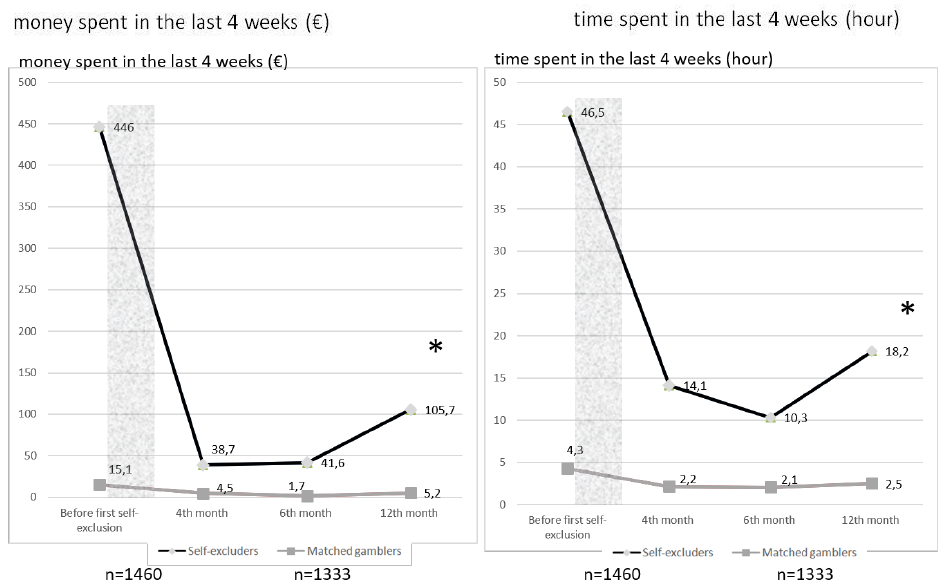
Figure 3. Evolution of money / time spent in the last 4 weeks ( € / hours) before and after a short self-exclusion ( n = 1460 and 1333). (* = p -value < 0.05—ANOVA between the mixed model with and the null model without the interaction of self-exclusion X time).